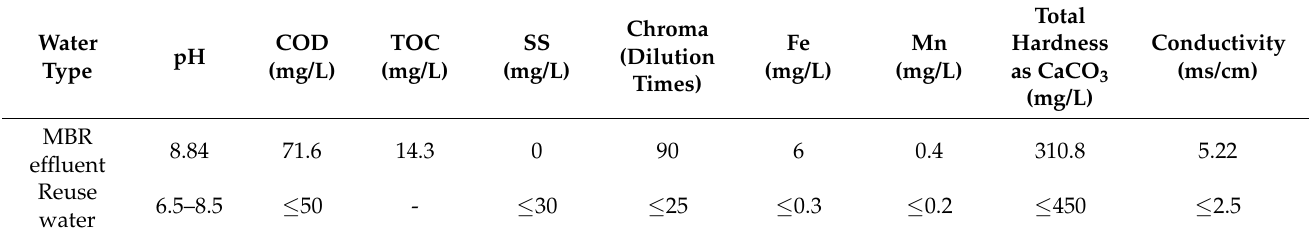
Table 2. MBR effluent quality and the TFDW reuse standard in